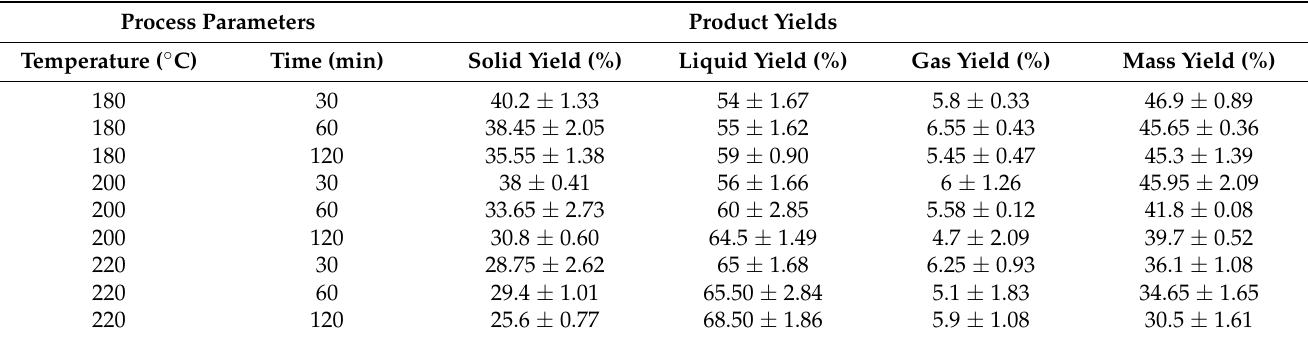
Table 1. The solid, liquid, and gas yield from HTC